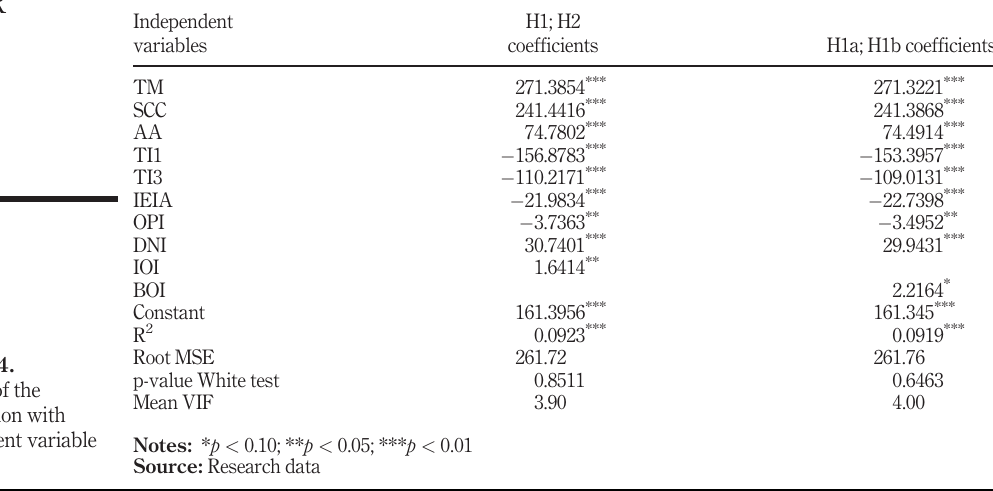
Table 4. Result of the regression with dependent variable